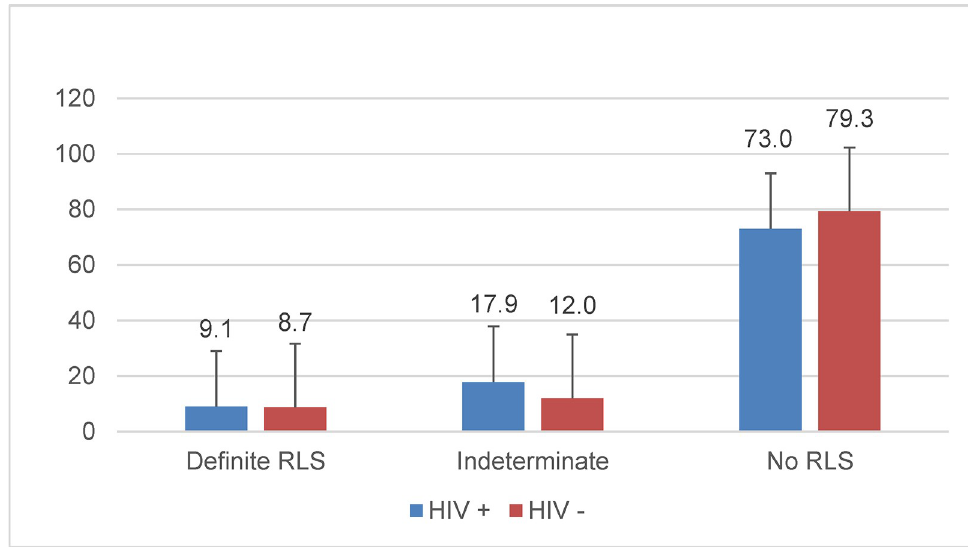
Fig 1. Unadjusted prevalence of RLS by HIV status. Data represent RLS status prevalence with error bars. https://doi.org/10.1371/journal.pone.0258139.g001 (HIV duration, CD4 count > 500, or viral load suppression) was associated with “indetermi- nate” RLS. In contrast, HIV disease duration was associated with “definite” RLS (OR 1.08; 95% CI 1.01–1.16) in the fully adjusted model. To assess the potential effects of disease duration, HIV disease duration and RLS prevalence were cross-tabulated. No cases of “definite RLS” Table 2. Adjusted odds ratio § for RLS status in men with and without HIV. Variables